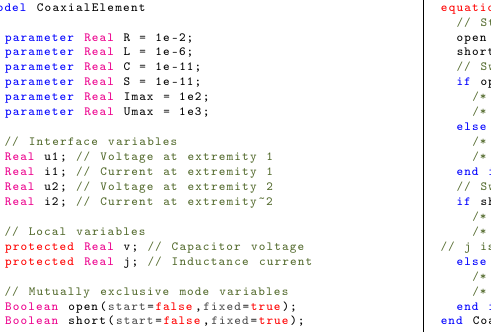
Figure 12. Equivalent electrical circuit of a faulty transmission line element. model CoaxialElement